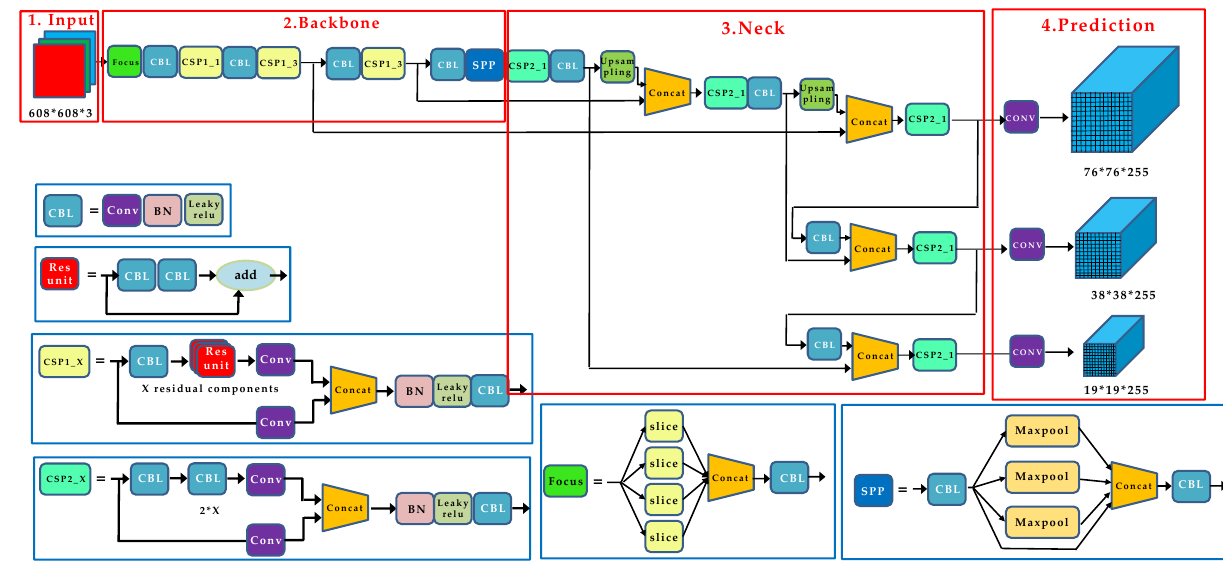
Figure 1. The YOLOv5s network structure.